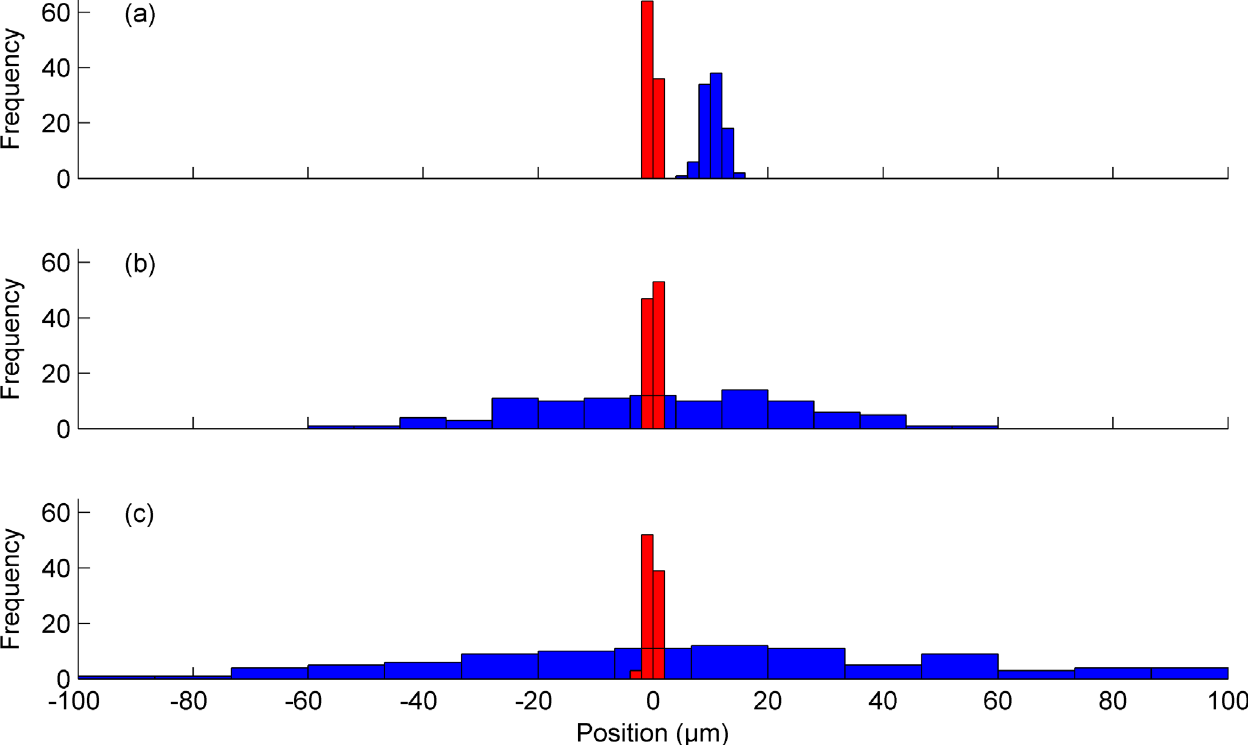
FIG. 19. Distributions of positions with feedback off (blue) and feedback on (red) for bunch 2 at P3 with incoming, uncorrected position jitters of (a) ∼ 2 μ m, (b) ∼ 22 μ m, and (c) ∼ 45 μ